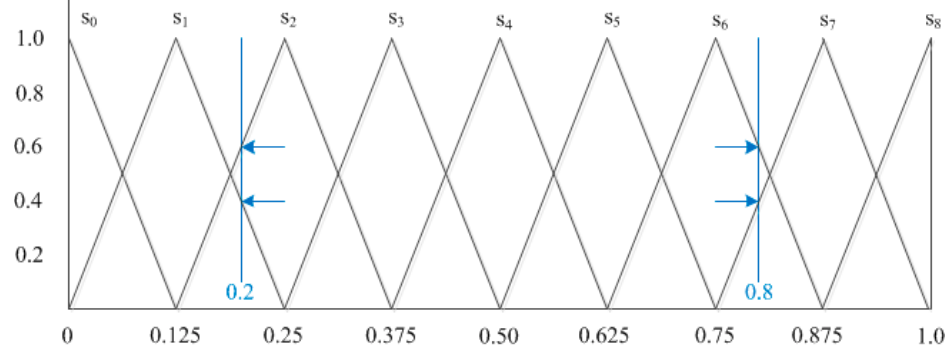
Figure 2. Transformation Relation between a Fuzzy Number and a 2 ‐ tuple Linguistic.